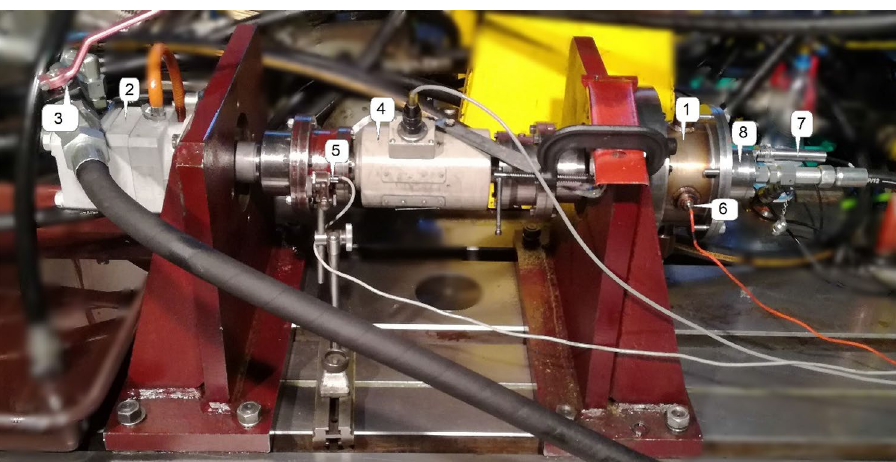
Figure 8. Test stand: 1—multidisc wet clutch testing device, 2—hydraulic motor, 3—shut-off valve, 4—torque transducer, 5—inductive sensor, 6—temperature sensor PT100, 7—displacement sensor, 8—hydraulic actuator.